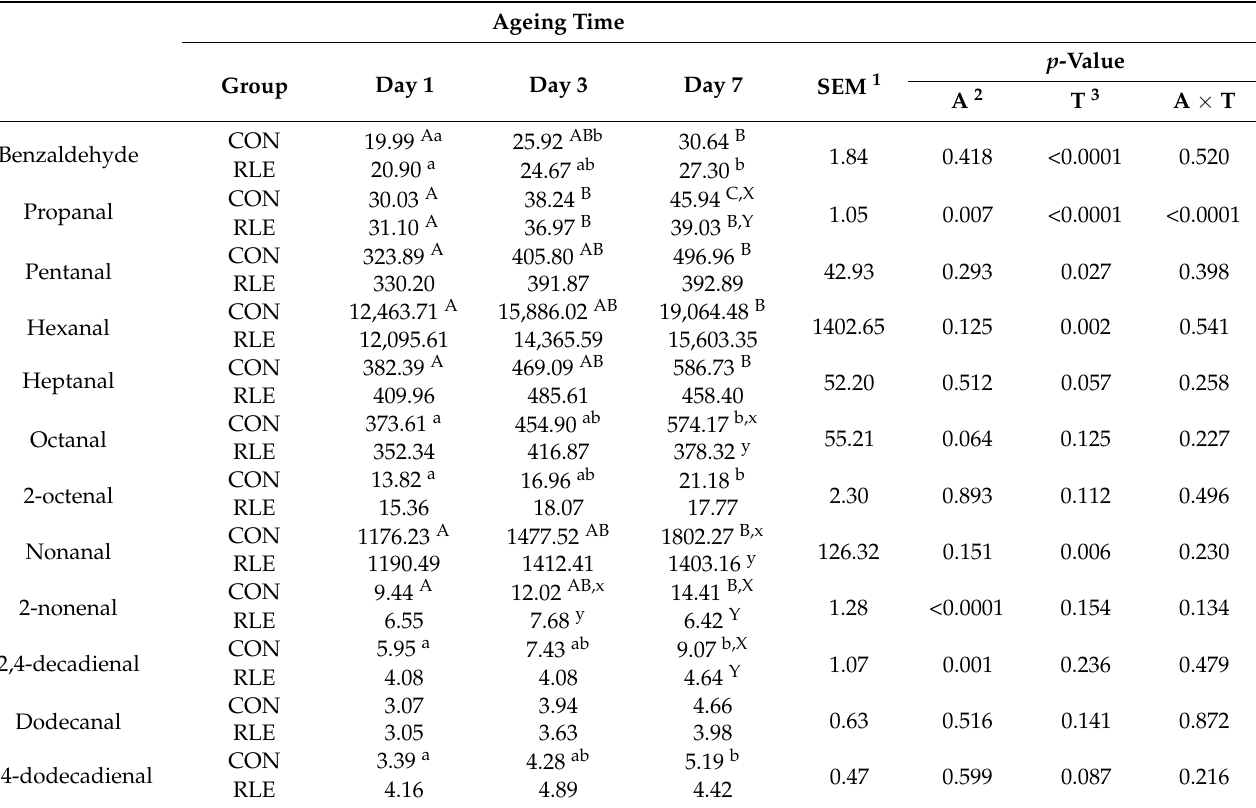
Table 3. Effects of anthocyanin diet addition and ageing on aldehyde volatile compounds of meat from goat kids ( n = 30 samples for each experimental group). Results are expressed as ng/g of